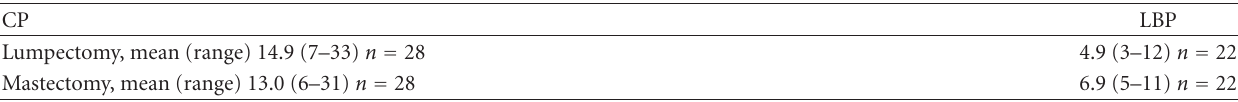
Figure 9: Seventy-one-year-old woman presenting with a palpable nodule of the right breast. (a) Right MLO mammogram with 14 mm stellate density. (b) MRI of right breast, sagittal reconstruction. The estimated overall extent of enhancing lesion 60mm. (c) Large-format pathology slide of lumpectomy specimen, sectioned in the sagittal plane. Overall extent of DCIS is 60 mm with a superimposed 15 mm invasive ductal carcinoma corresponding to stellate density (H&E). (d) DCIS grade 3 located 2 mm from the anterior-superior surgical margin (H&E, 100x). Table 7: Average number of conventional tissue blocks per case, year 2004-2005. Comparison between conventional pathology (CP) and LBP Program (LBP). N =